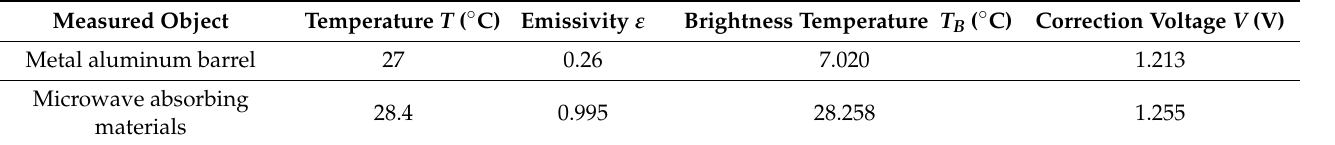
Figure 5. The physical picture of the calibration source. ( a ) Metal aluminum barrel; ( b ) Microwave absorbing material. Table 4. Calibration